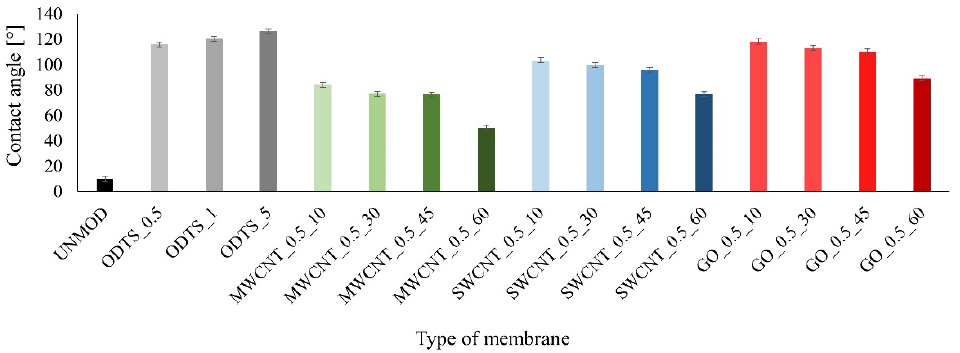
Figure 5. Results of the contact angle measurement for the test membranes.